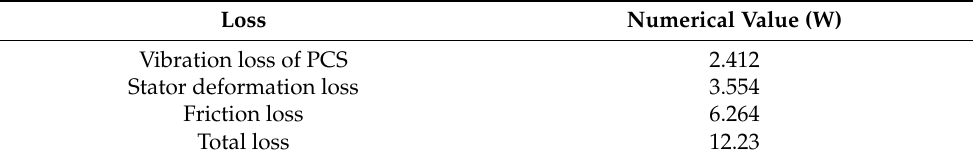
Table 4. Loss of ultrasonic motor.